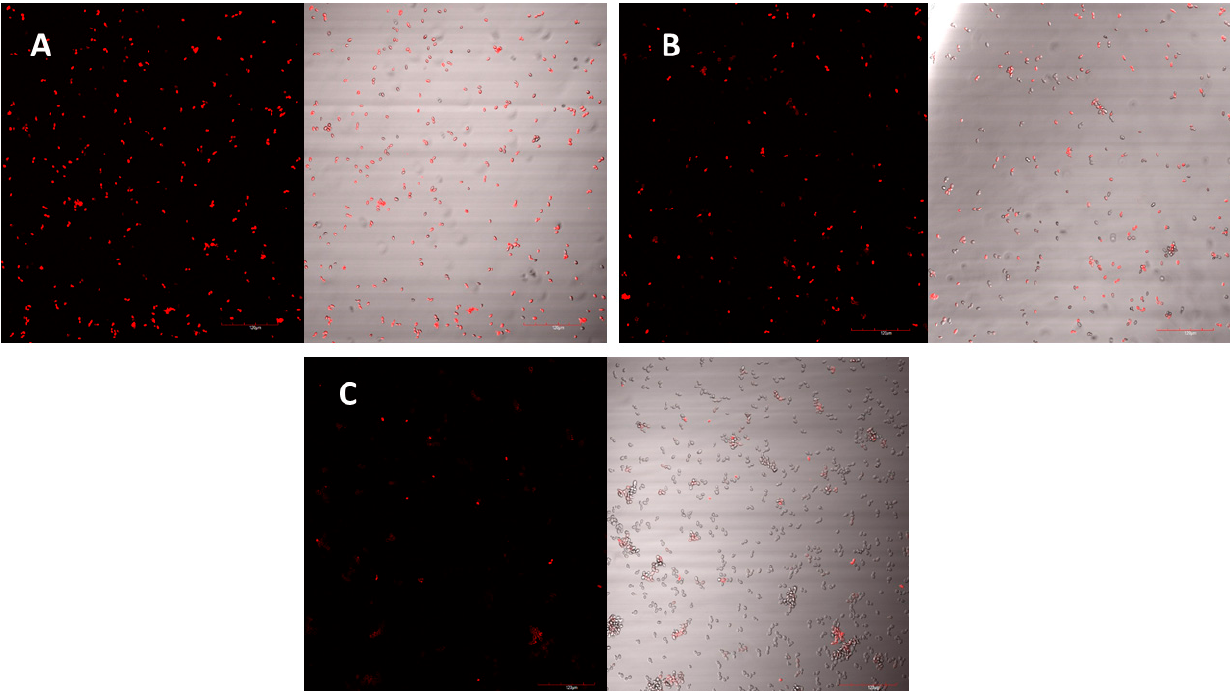
Figure 4. Z. bailii membrane permeabilisation observed under the confocal laser scanning microscope (CLSM) as a result of the peptide at concentrations of ( A ) 400 μ g/mL, ( B ) 200 μ g/mL and ( C ) 100 μ g/mL.